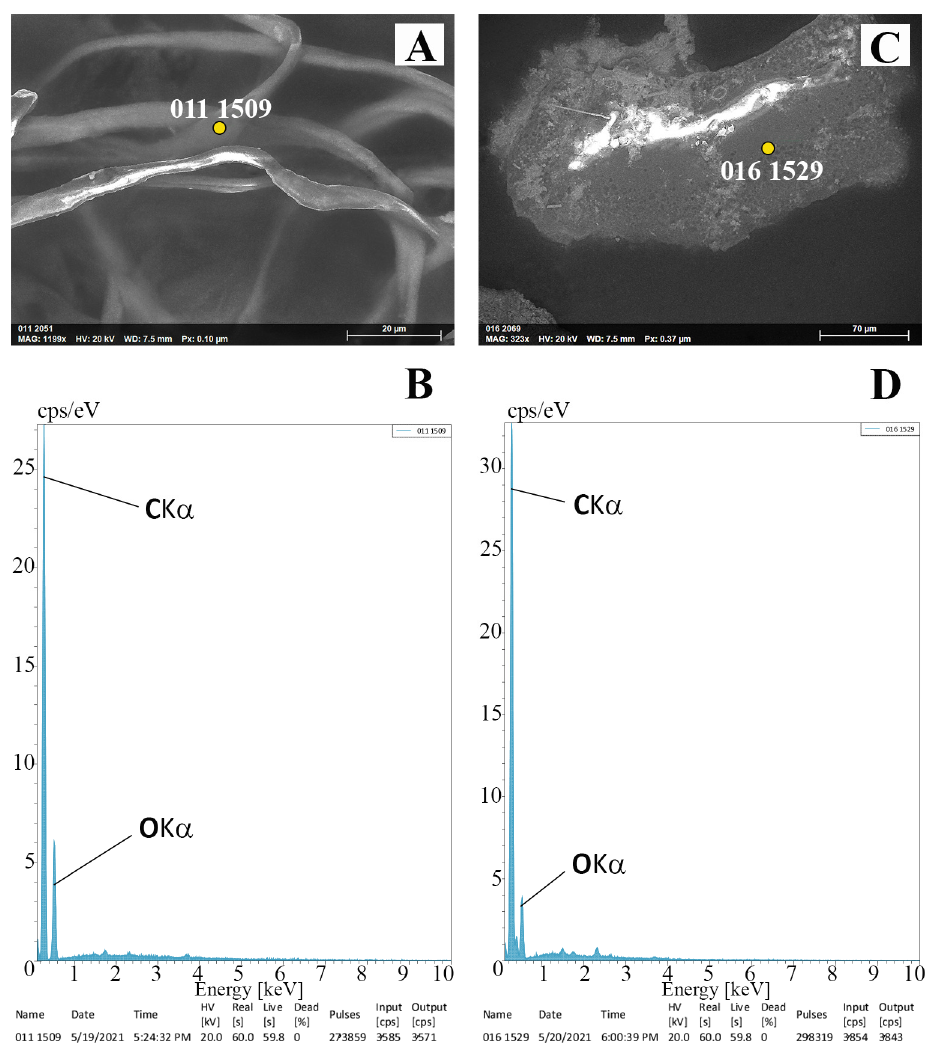
Figure 6. SEM/EDX example of images and microanalysis from canonical microplastic. ( A , C) SEM images and ( B , D ) EDX spectra from ( A , B ) a typical microplastic fibers and ( C , D ) typical microplastic debris extracted from the gut content of H. tubulosa from Salento peninsula.